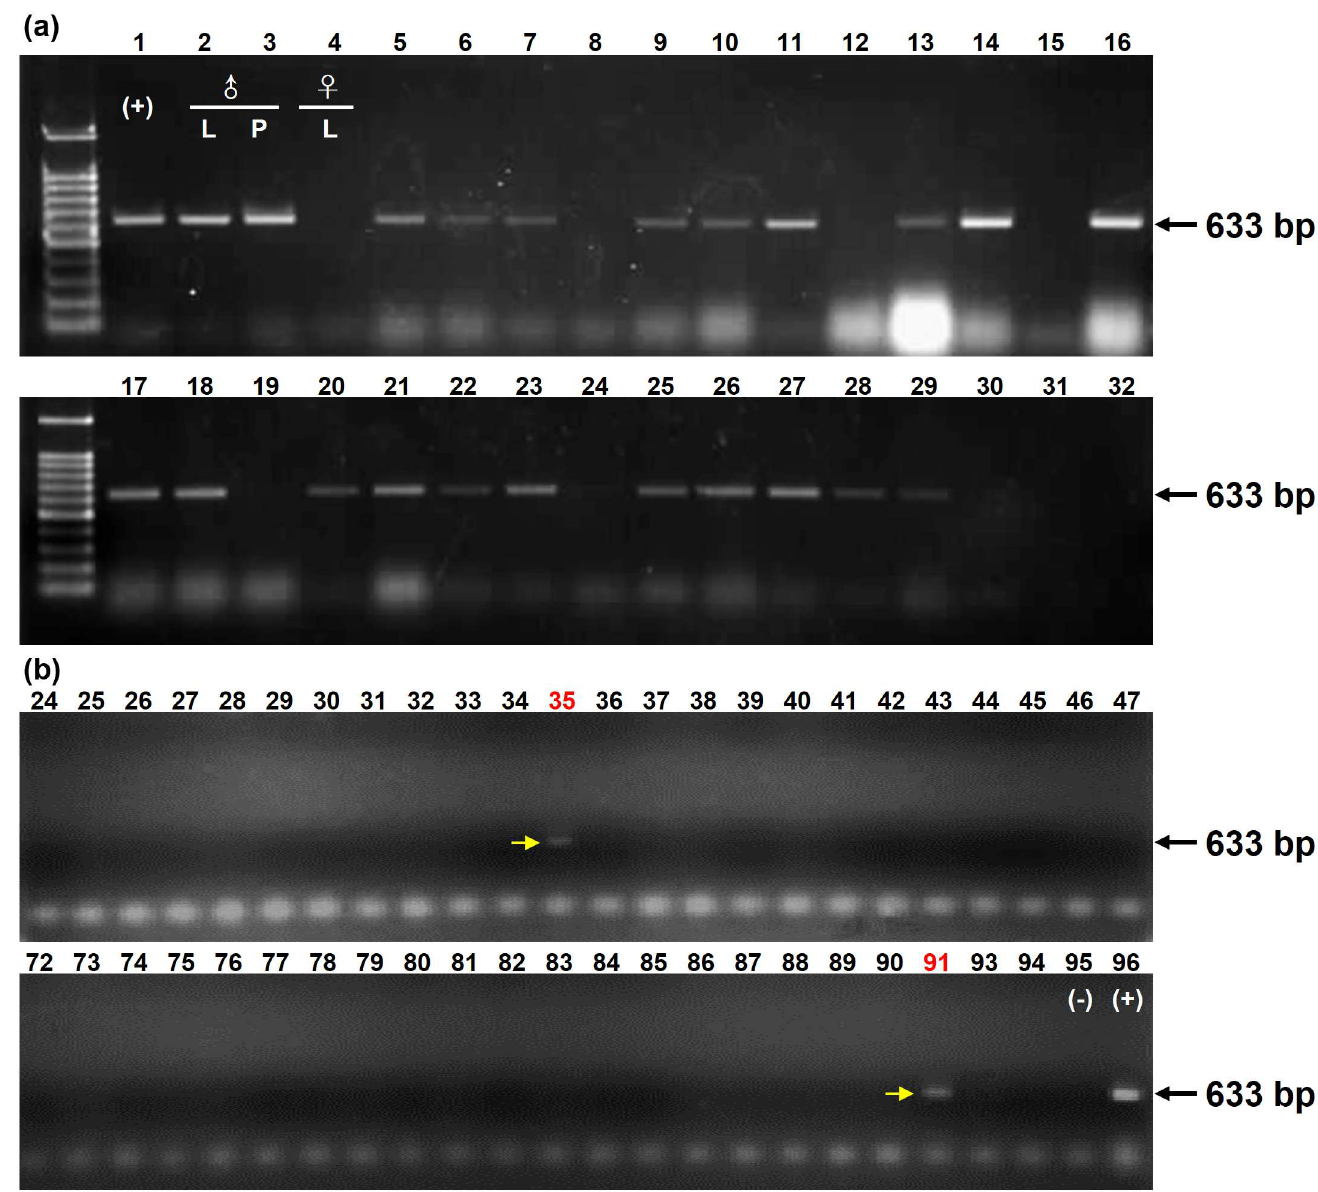
Fig 3. Agarose gel electrophoresis of products amplified from non-transgenic and transgenic poplars (a) and partial seeds collected at site No. 4 (b). (a) Lane 1, Bt plasmidas a positive control; Lane 2, leaves of Bt transgenicpoplar; Lane 3, pollenof Bt poplar; Lane 4, leaves of non- transgenic poplar; Lanes 5–32, partial results of Bt detection from the offspring from controlledcrosses between‘Pioneer’poplarand Bt transgenic poplar. (b) Lanes 24–47and Lanes 72–94,partial results of Bt seed detectionat site No. 4; Lane 95, leaves of non-transgenic poplar; Lane 96, Bt plasmidas a positive control. Lanes 35 and 91 are DNA samplesshowingpositive Bt (arrow) detection. The amplifiedfragment was confirmedby sequencing (S2